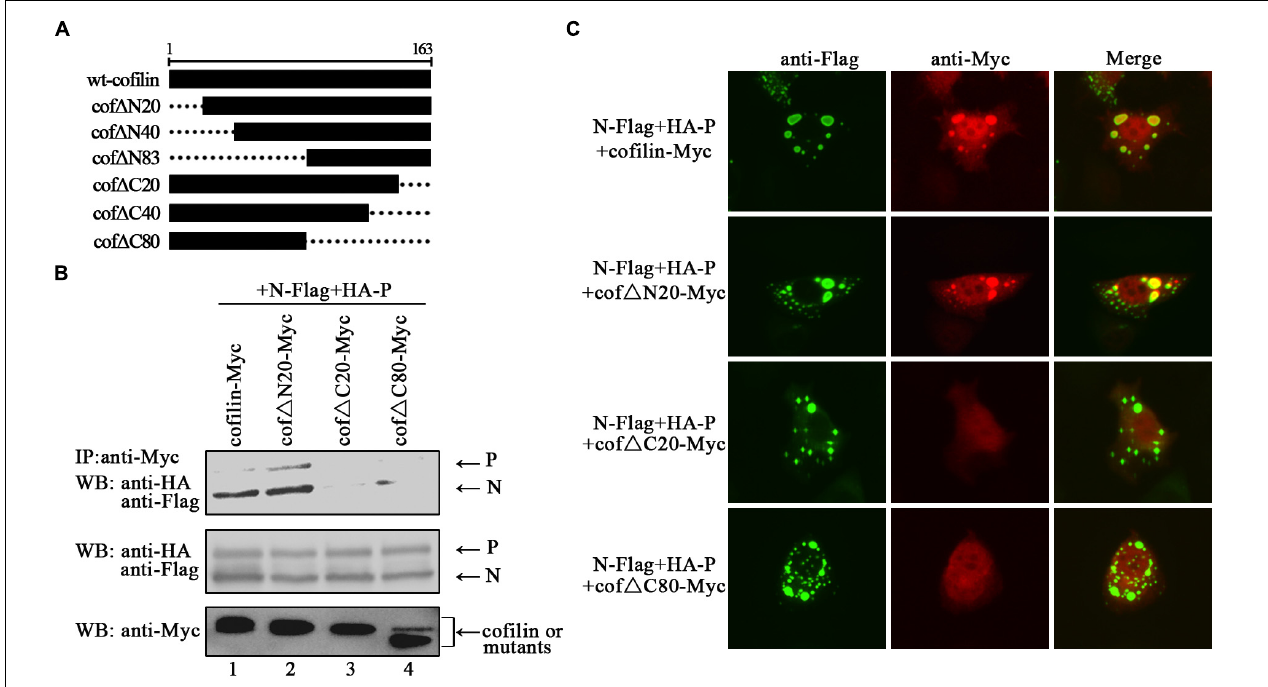
FIGURE 7 | The C-terminus of cofilin is indispensible for the interaction with N protein. (A) Schematic of truncated mutants of cofilin. (B) 293T cells were cotransfected with plasmids encoding N-Flag, HA-P, and wild type or mutant cofilin as indicated. At 48 h after transfection, the cells were collected and processed to co-IP assays as described in the legend of Figure 2A . Proteins were precipitated with anti-Myc antibody and examined by WB. (C) Hela cells were transfected with plasmids encoding N-Flag, HA-P and wild type or mutant cofilin as indicated. At 24 h after transfection, the cells were fixed, and rabbit Flag primary antibody and goat anti-rabbit AF488 were used to stain N, and mouse Myc primary antibody and goat anti-mouse AF568 were used to stain wild type and mutant cofilin. Images were analyzed via IF